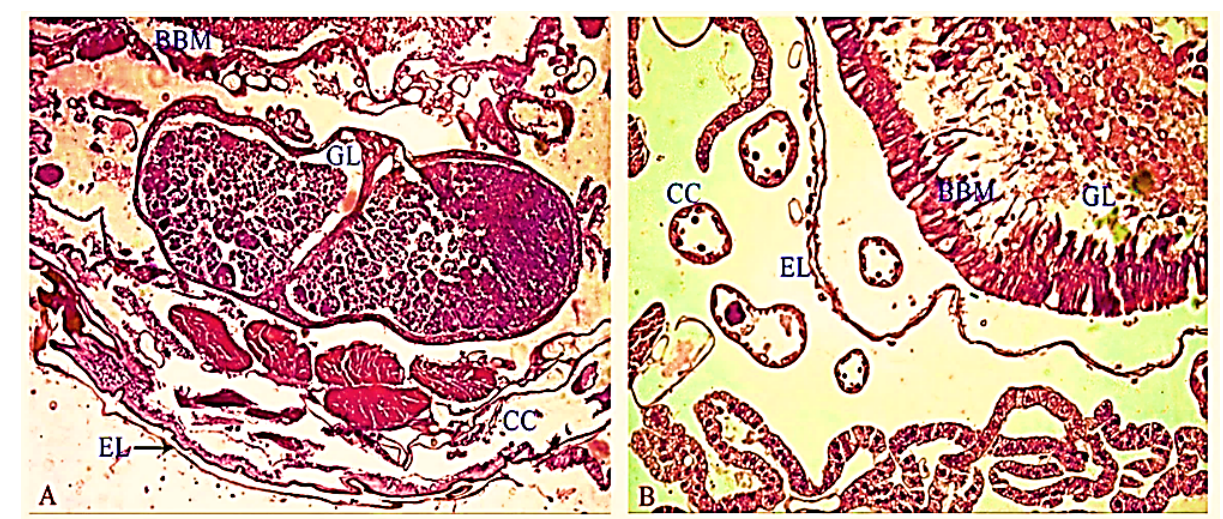
Figure 5. Histological section of the midgut region of fourth instar larvae of S. litura ( A ) control (CC—columnar cells; EL—epithelial layer; BBM—brush border membrane; GL—gut lumen). ( B ) Treated concentration of 6ppm of Db-Precocene I (CC—columnar cells; EL—epithelial layer; BBM—brush border membrane; GL—gut lumen).